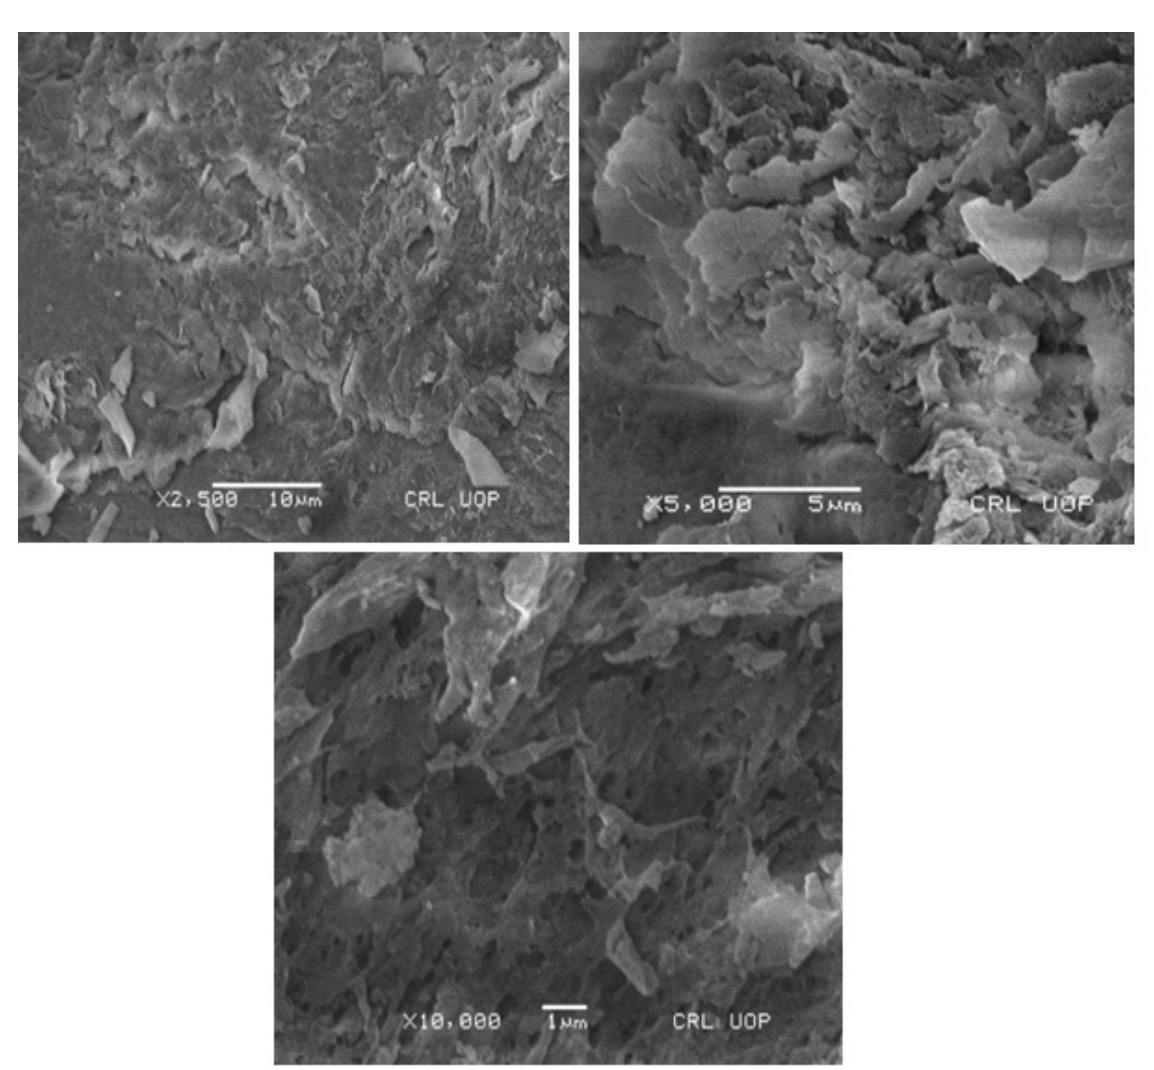
Figure 10. SEM micrographs of developed Na-Alg/CP co-poly(methacrylate)